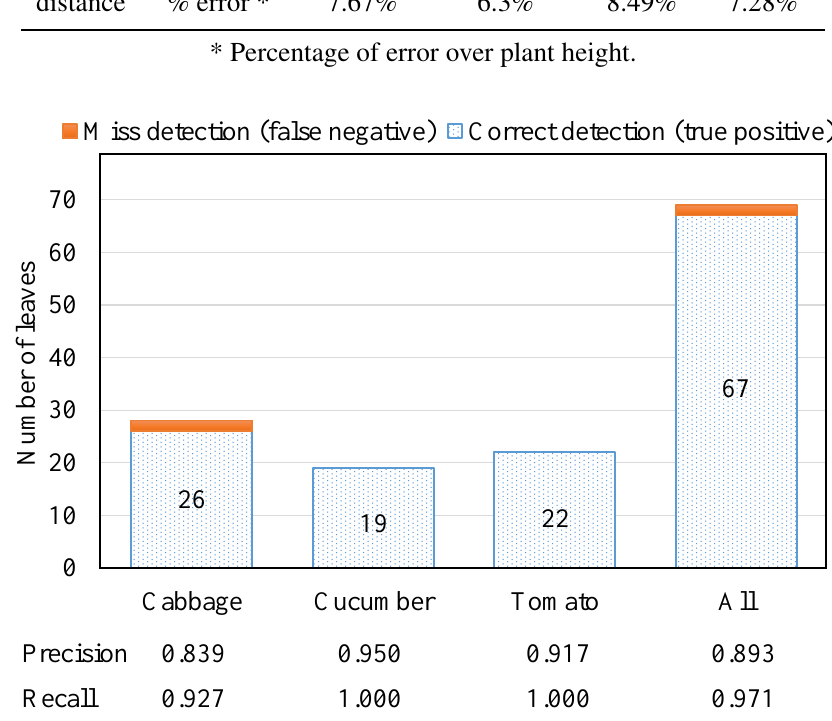
Figure 11. Evaluation of the number of detected leaves/leaflets in terms of precision and recall, from the 3D reconstructed cabbage, cucumber and tomato